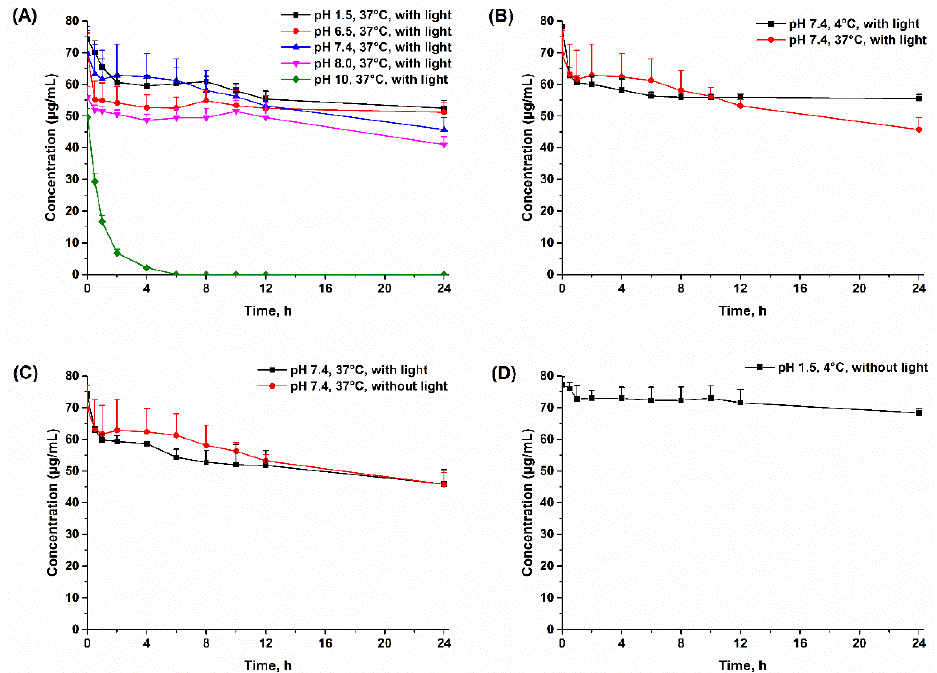
Figure 2. Effects of different conditions on the degradation of 80 μg/mL physalin A at 24 h. Data are presented as mean ± SD ( n = 6). ( A ) Physalin A was incubated with light in buffer solutions with different pH values at 37 °C; ( B ) Physalin A was incubated with light in a buffer solution of pH 7.4 at 4 °C and 37 °C; ( C ) Physalin A was incubated in a buffer solution of pH 7.4 at 37 °C, with or without light; ( D ) Physalin A was incubated in a buffer solution of pH 1.5 at 4 °C, without light.